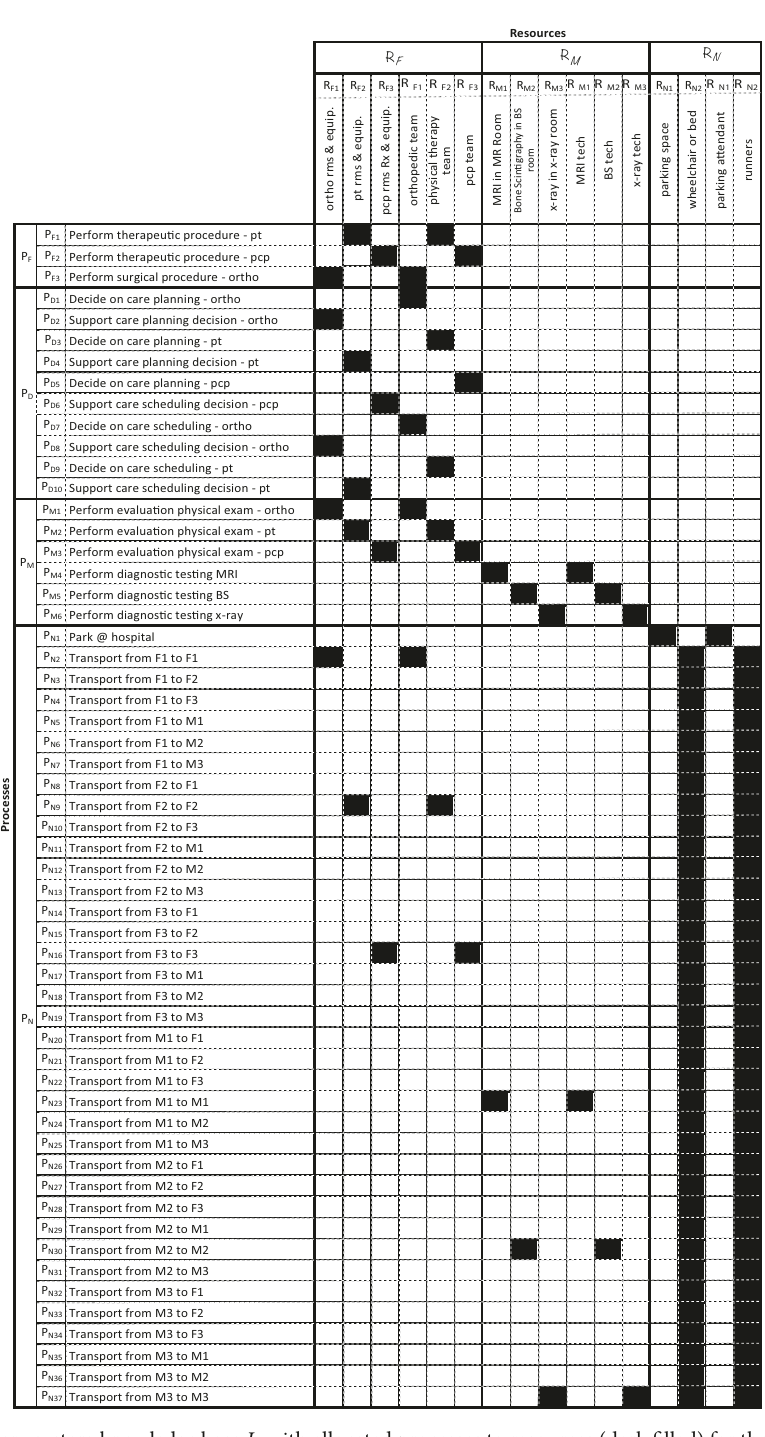
between the existence and the availability of the